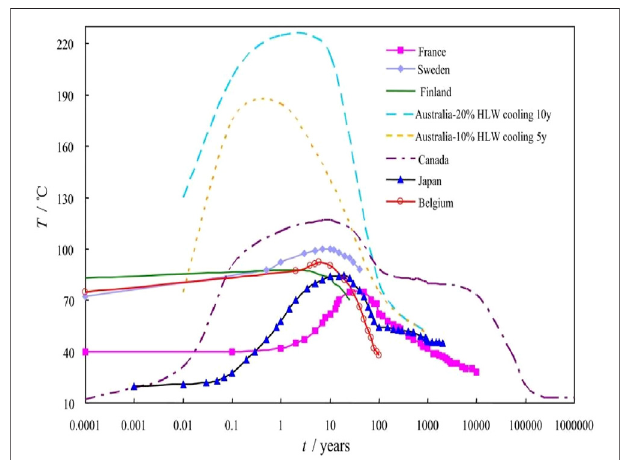
FIGURE 2 | Temperature evolution with time in the near- fi eld environment of the HLNW container.